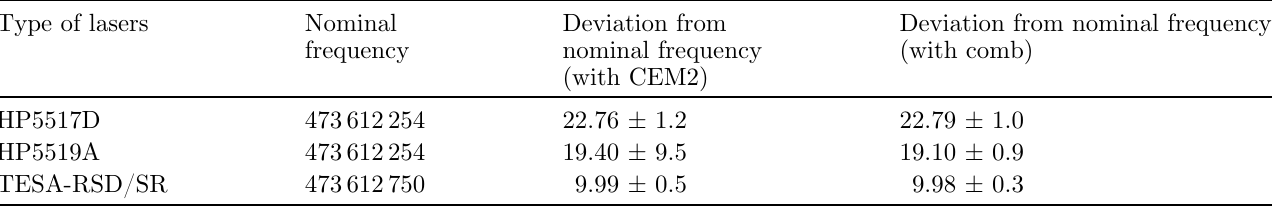
Table 1. Frequencies of lasers under calibration measured by CEM2 and frequency comb printed as a difference from nominal frequency values. All values in MHz.